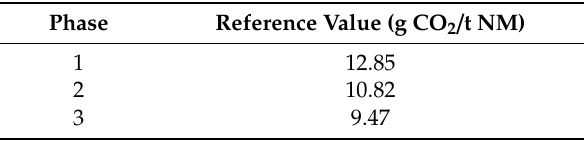
Table 14. EEDI reference values for a cruise ship of 140,000 GT.